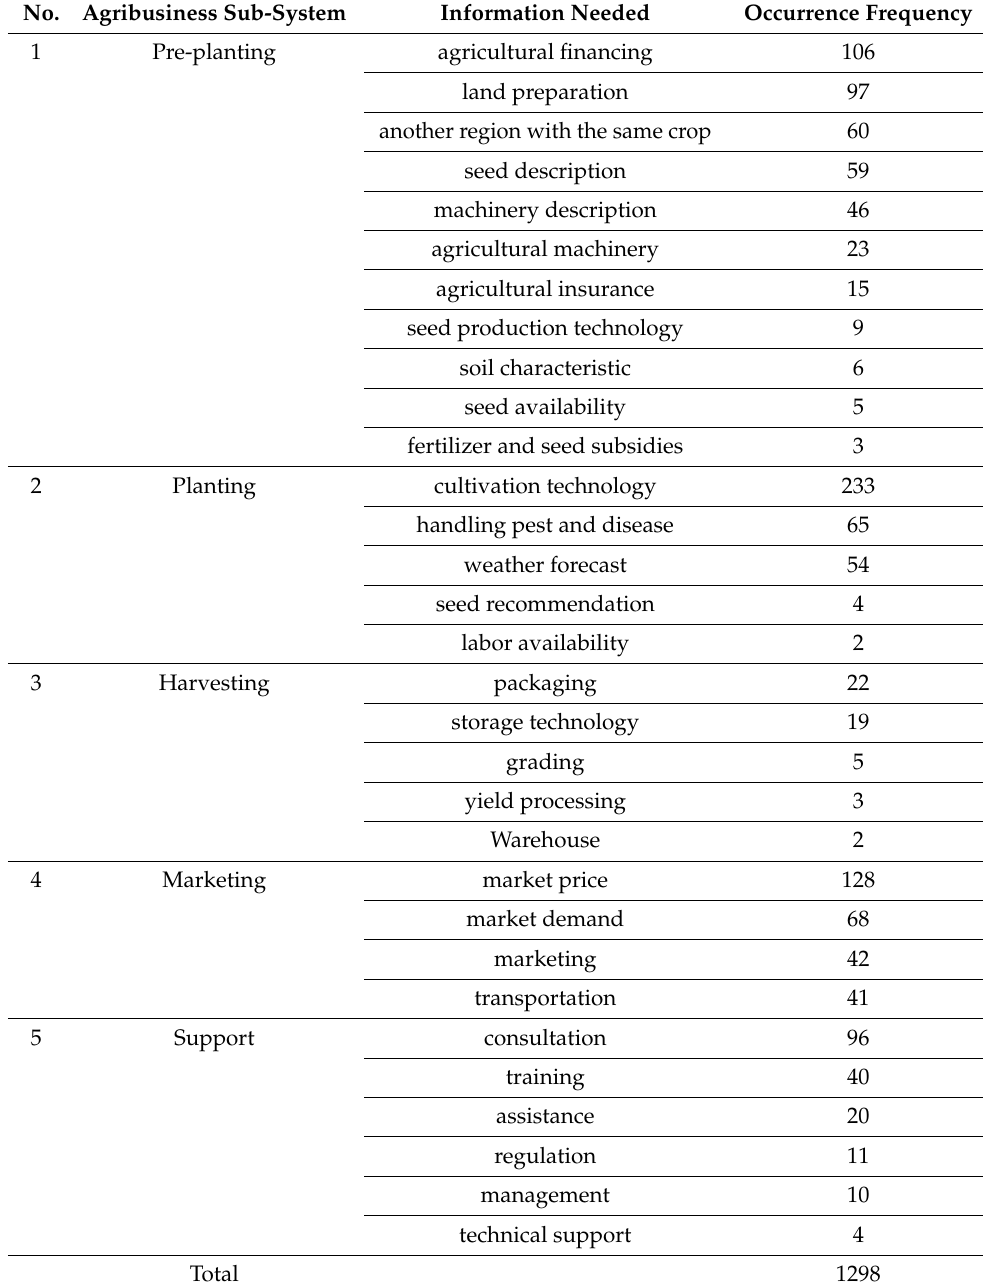
Table A1. The Frequency of Occurrence of Any Information Needed by Respondents in Sukabumi and Bandung Barat